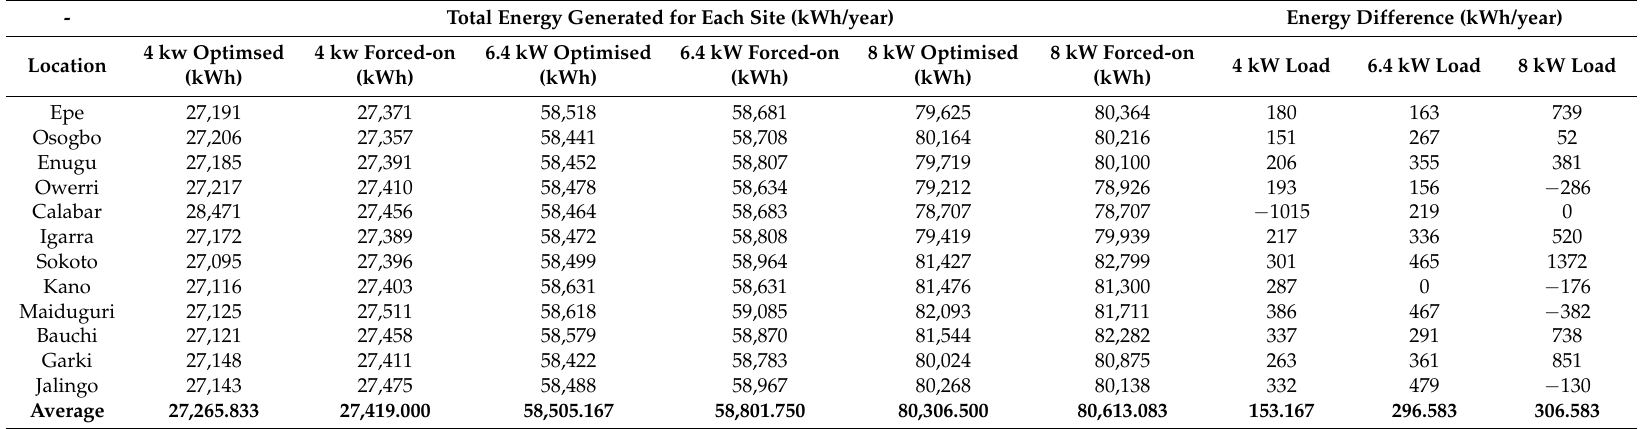
Table 5. Total energy generated for each site (kWh/year) and the energy difference for the